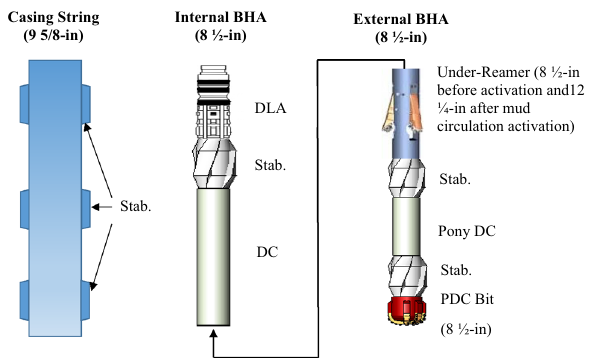
Fig. 15 Schematic of the drill string in casing while drilling (CWD) including the casing string (9 5/8-in.) and the BHA for deviation con- trol in a vertical 12 ¼-in. hole of Kupal field (modified after